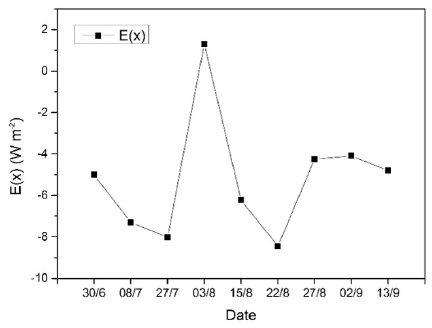
Figure 11. Expected error values based on Hypothesis 1 for the nine